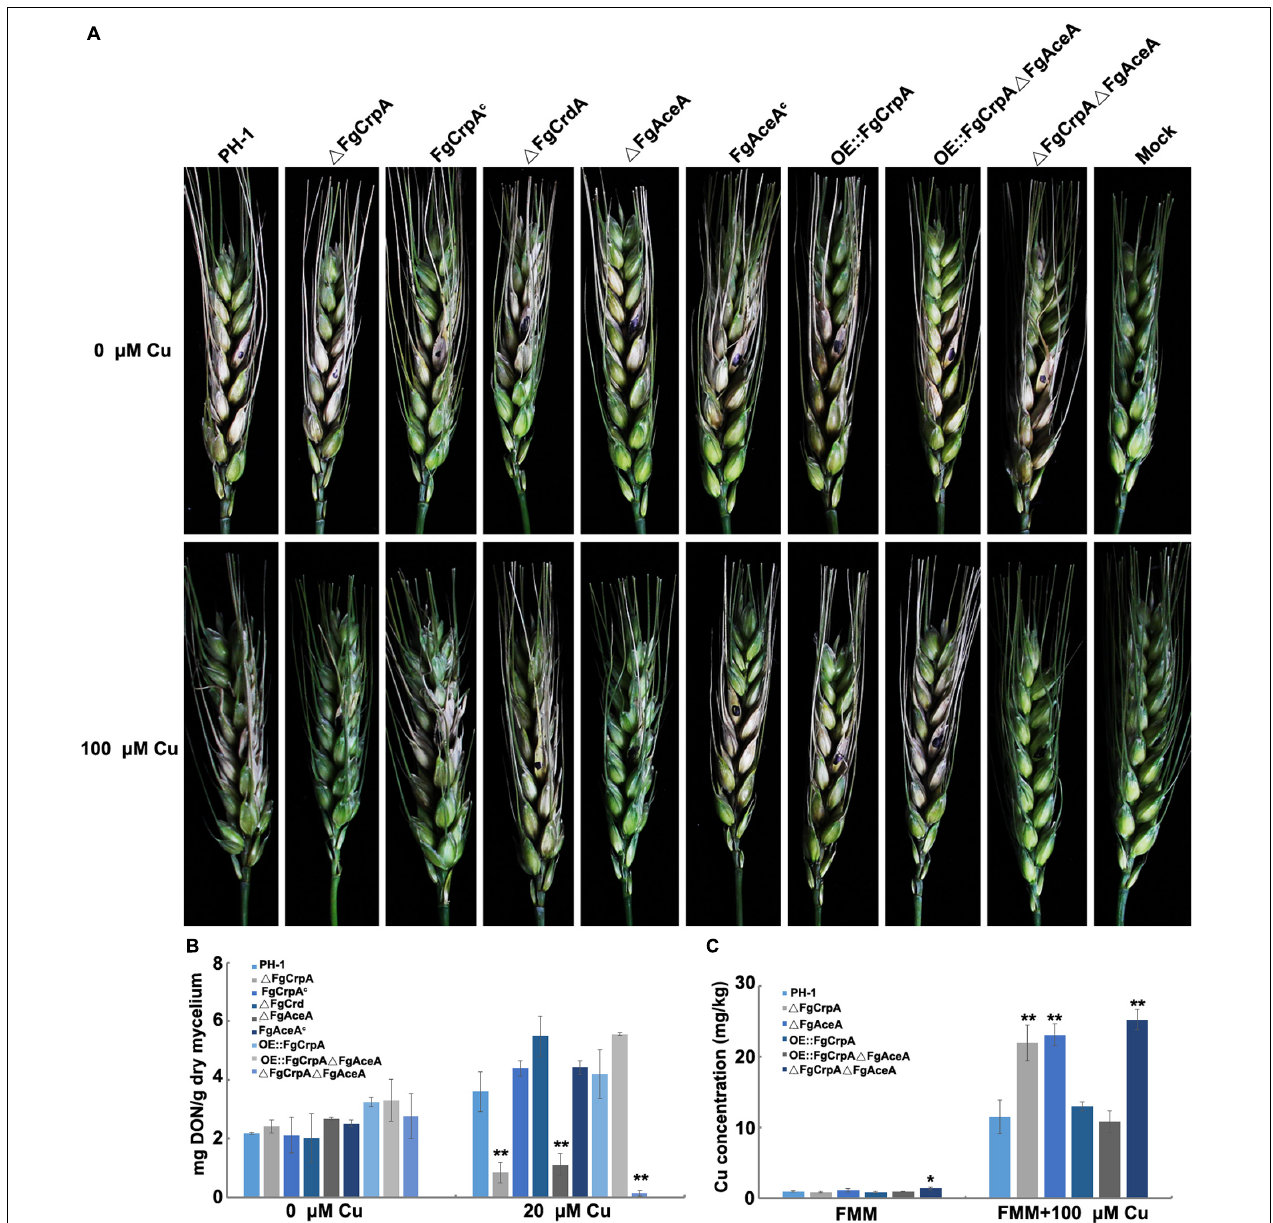
FIGURE 6 | Comparisons of virulence, DON accumulation and Cu concentration between wild-type strain PH-1 and its mutants. (A) Difference in virulence of F. graminearum strains inoculated on Cu treated and untreated flowering wheat heads. (B) Difference in the ability of DON accumulation virulence of F. graminearum strains inoculated in 30 ml liquid TBI (inoculum: 10 5 spores) with or without 20 µ M Cu and cultured at 28 ◦ C for 7 days. (C) Difference in Cu concentration in mycelium collected from the wild-type strain PH-1 and its mutants treated or untreated with 100 µ M Cu for 12 h. A t -test was performed to determine significant differences, * p < 0.05, ** p <